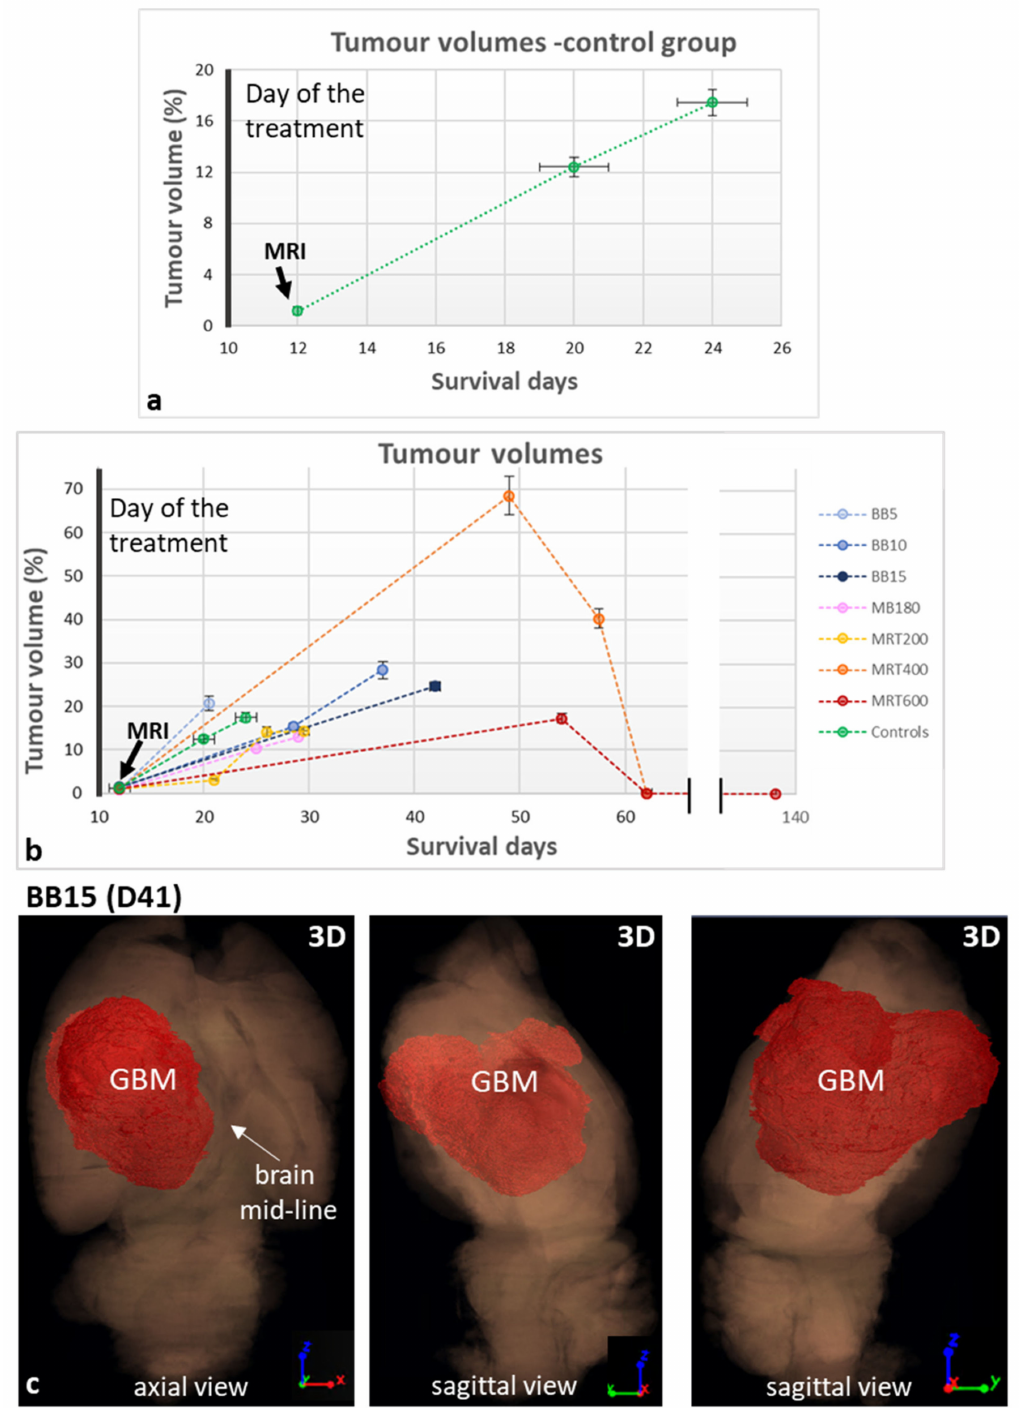
Figure 6. Quantification of tumor volumes for the GBM-control group ( a ) and all the groups involved in the study ( b ) as a function of the survival days which are counted starting from the tumoral cells implantation day (D0). All the values are extracted from XPCI-CT images but the one at day 12, which is in-vivo MRI-based. Tumor volumes are given as a percentage of the entire brain volume; values of animals belonging to the same group with survivals within three days are averaged and the mean values are reported in the graphs. ( c ) Reports three different orientations (axial and two different sagittal views) of the 3D rendering of a BB15 irradiated rat brain showing how the tumor develops into the brain volume shifting the brain mid-line. The full organ dataset is rendered in semi-transparency while the tumor is colored in red and co-registered as a solid